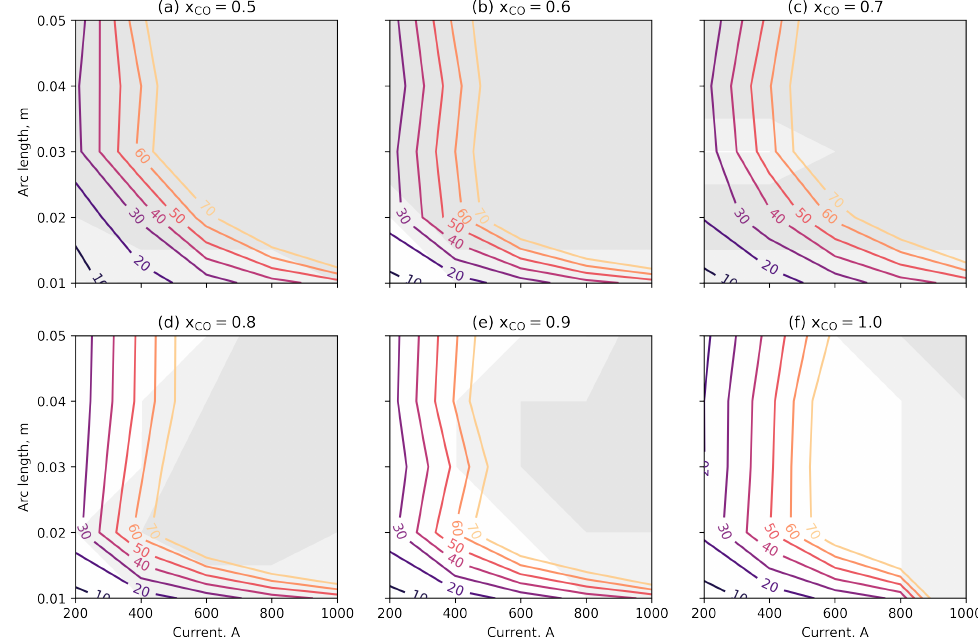
Figure 12. Furnace operability analysis, showing the power in kW as coloured contours and arc behaviour as shades of grey (white is steady state, and dark grey is fully